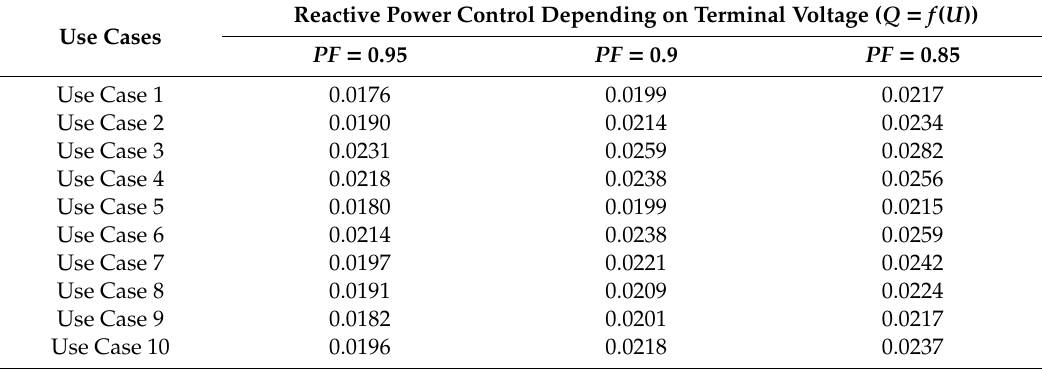
Table A9. Reactive power control depending on terminal voltage: Losses.